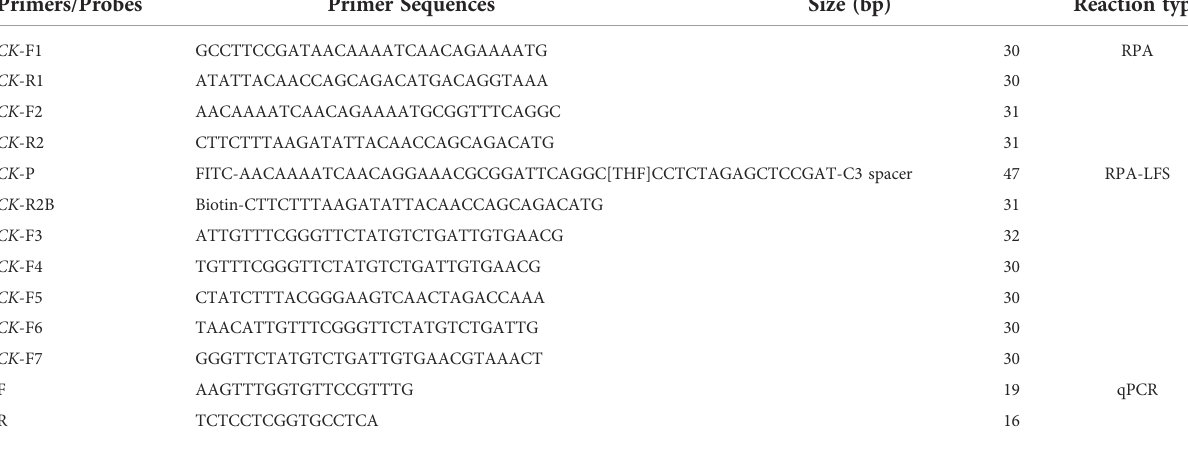
TABLE 1 Primers and probe based on ITS2 of C. krusei